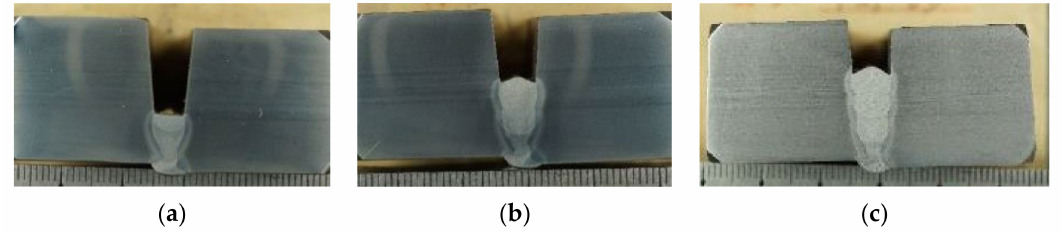
Figure 4. Weld pass filling layer appearance: ( a ) concave; ( b ) convex; ( c )